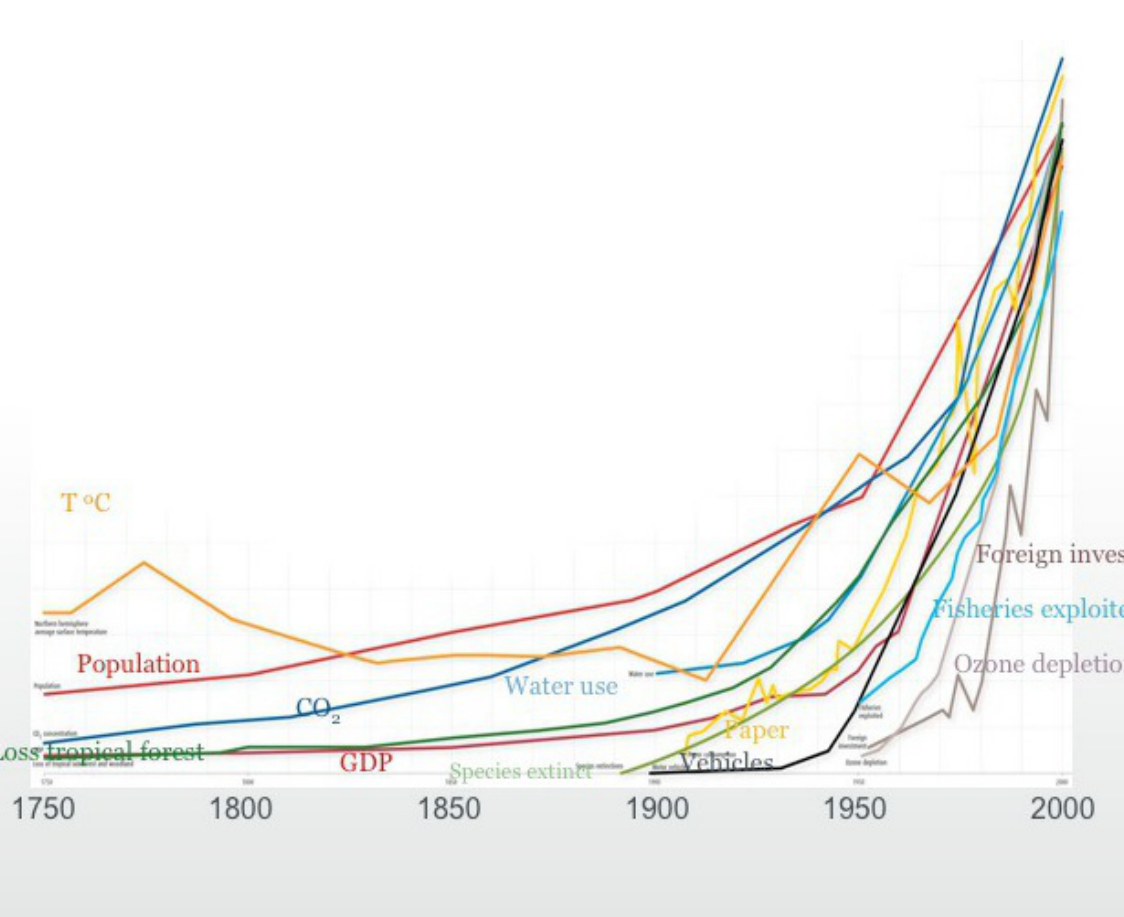
Fig. 2. Trends and